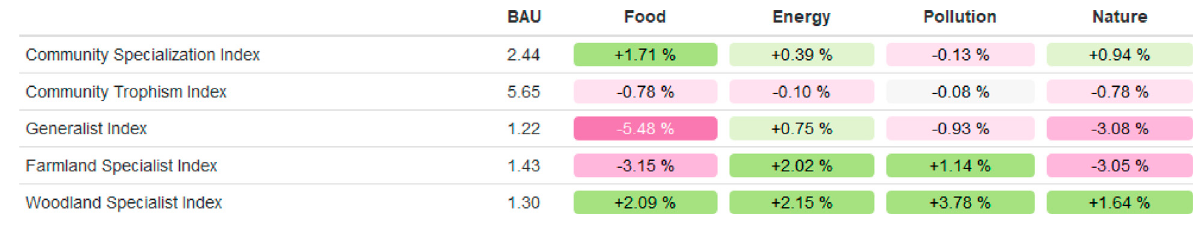
TABLE 6 Crossed marginal impacts of the 4 public policy scenarios in regards with the BAU on ecological indicators. Indicators levels of the BAU are given for reference. Note that all indicators are dimensionless (for indicators computation details see 6.4). Table reads as follow: the Food scenario increases the Community Specialization Index by 1.71% in comparison to the